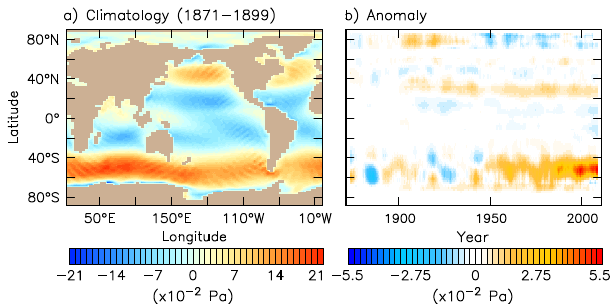
Figure 1. (a) The surface zonal wind stress climatology of 20CR over 1871 to 1899 and (b) temporal changes in zonal mean stress relative to the climatology.